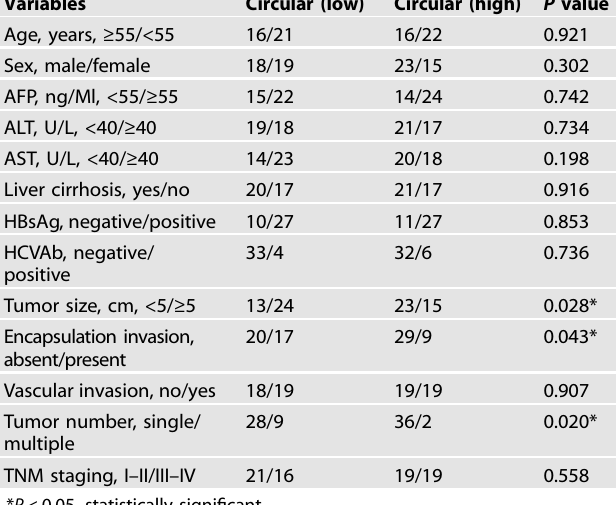
Table 2. Correlation between circUBE2J2 and clinicopathological characteristics in 75 HCCs.